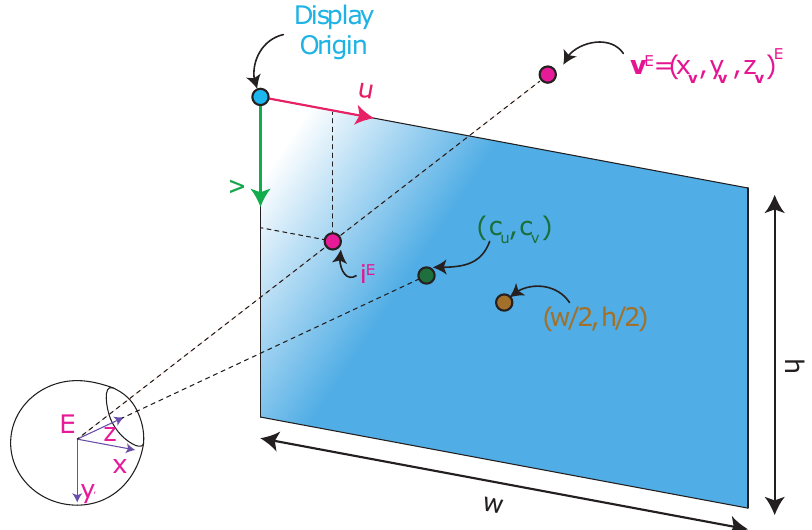
Figure 1. 3D representation of the off-axis eye–display pinhole model comprising the eye as the projection center and the see-through virtual screen as the imaging